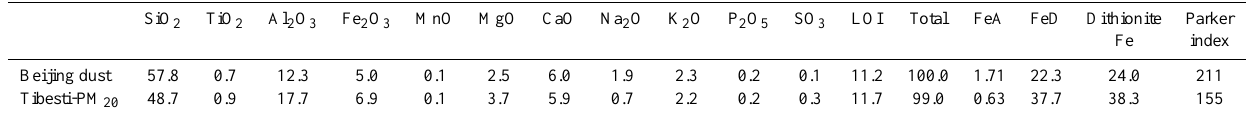
Table 1. Chemical composition of major elements, FeA, FeD, dithionite Fe, and Parker weathering index of Beijing and Tibesti-PM 20 sample.